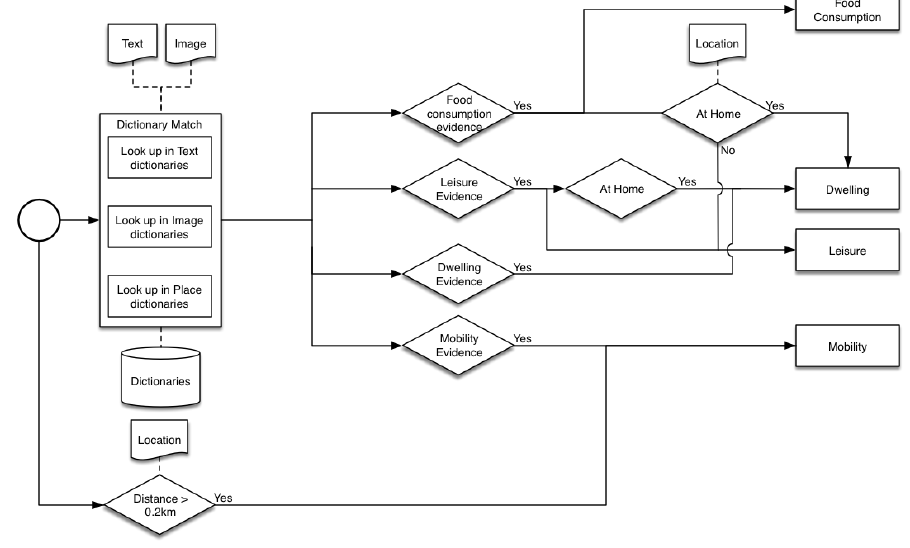
Figure 6. Illustration of the rule-based